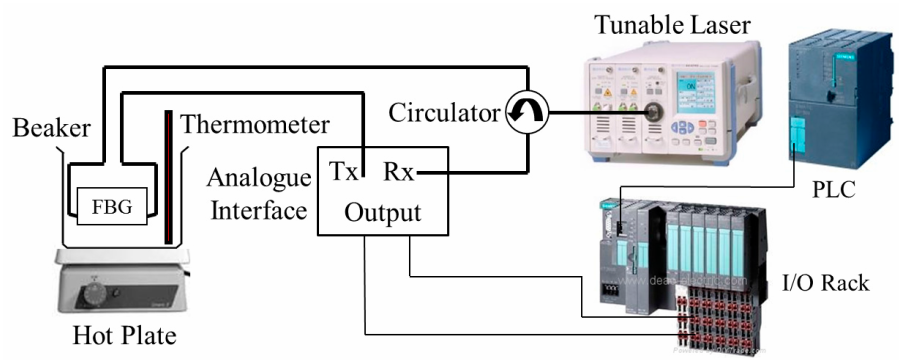
Figure 9. Setup for the temperature characterisation